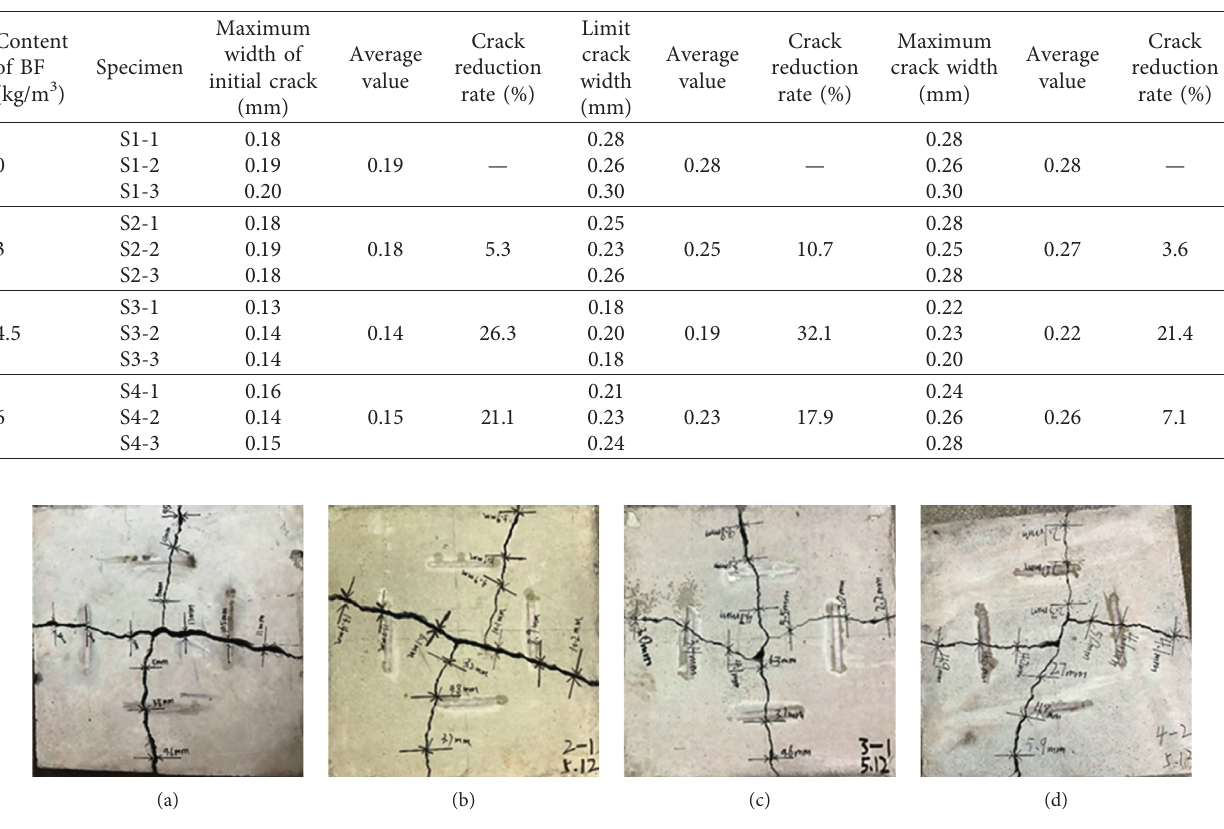
Table 6: Crack development law of BF shotcrete square slabs.